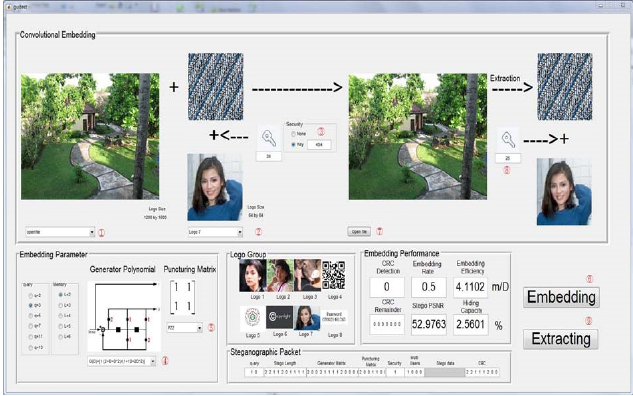
Figure 13. GUI of the image steganography system.